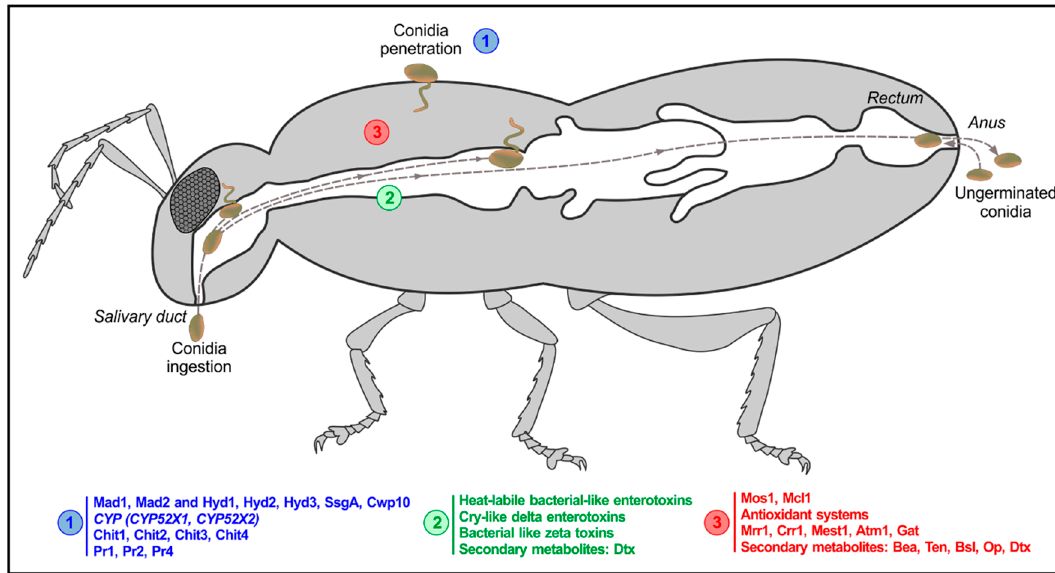
Figure 1. Alternative routes of entry to a host for an entomopathogenic fungus. The fungal genes involved in conidial penetration through the cuticle are shown in blue (1); the fungal genes proposed to participate in oral infection are shown in green (2); and the fungal genes expressed into the hemolymph are shown in red (3).